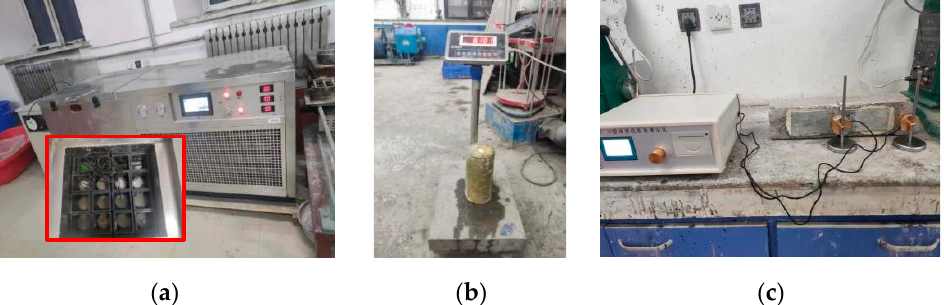
Figure 3. Freeze–thaw cycle and test: ( a ) freeze–thaw cycle experimental diagram; ( b ) mass weight test; ( c ) dynamic modulus of